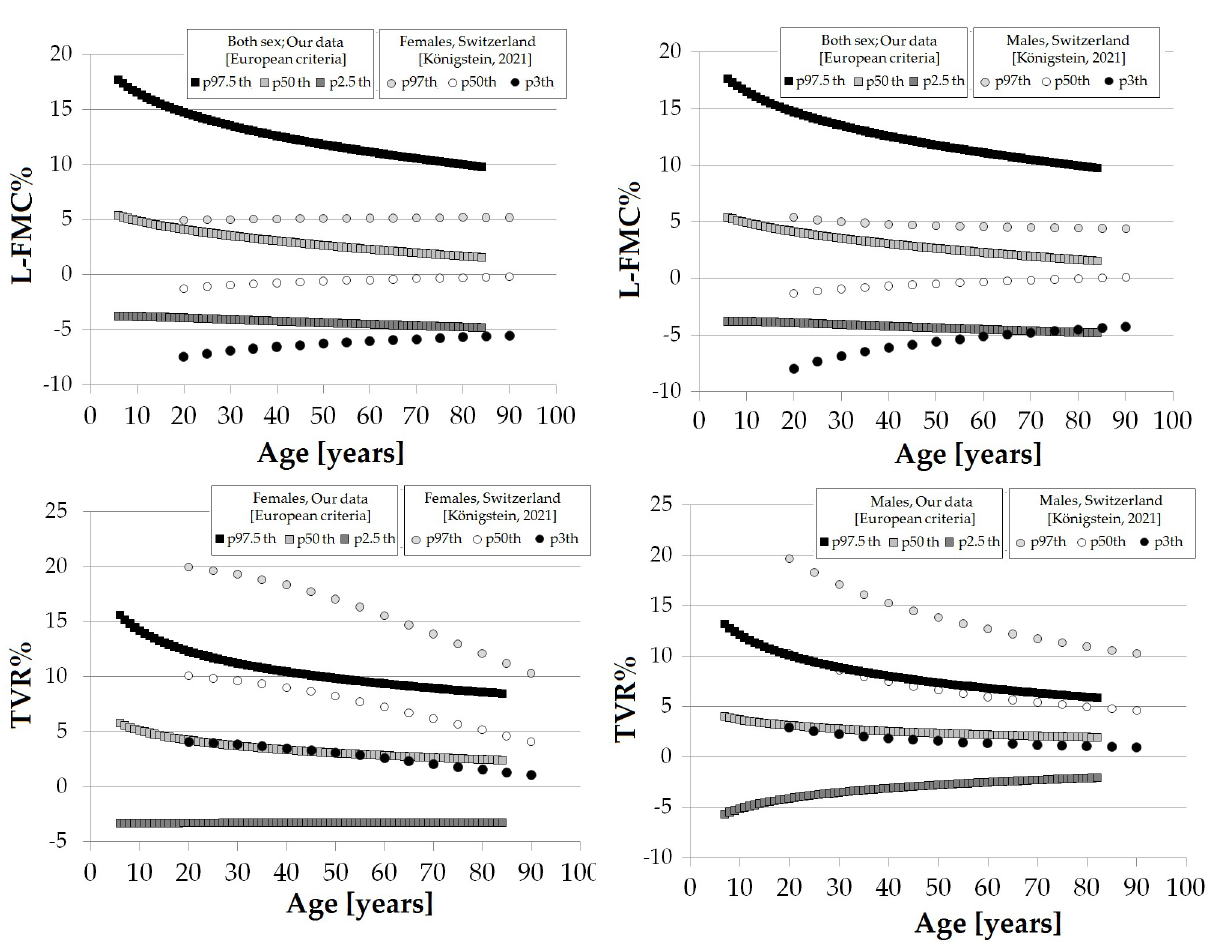
Fig 12. Comparative age-related L-FMC% and TVR%